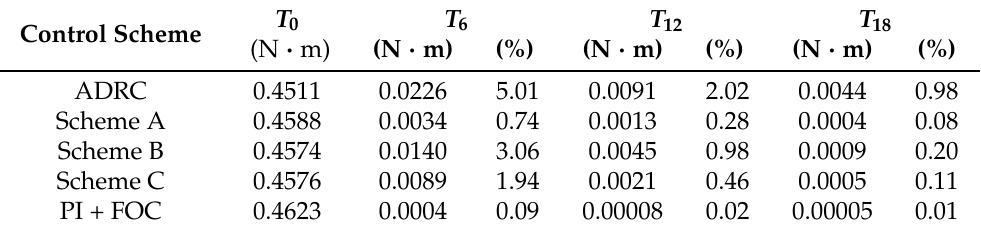
Table 6. Harmonic components of the motor torque under different control